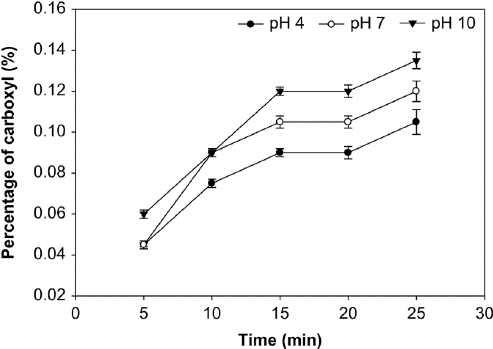
Figure 6. The effect of time on carboxyl group content at various pH with the starch concentration of 30% ( v / w ).